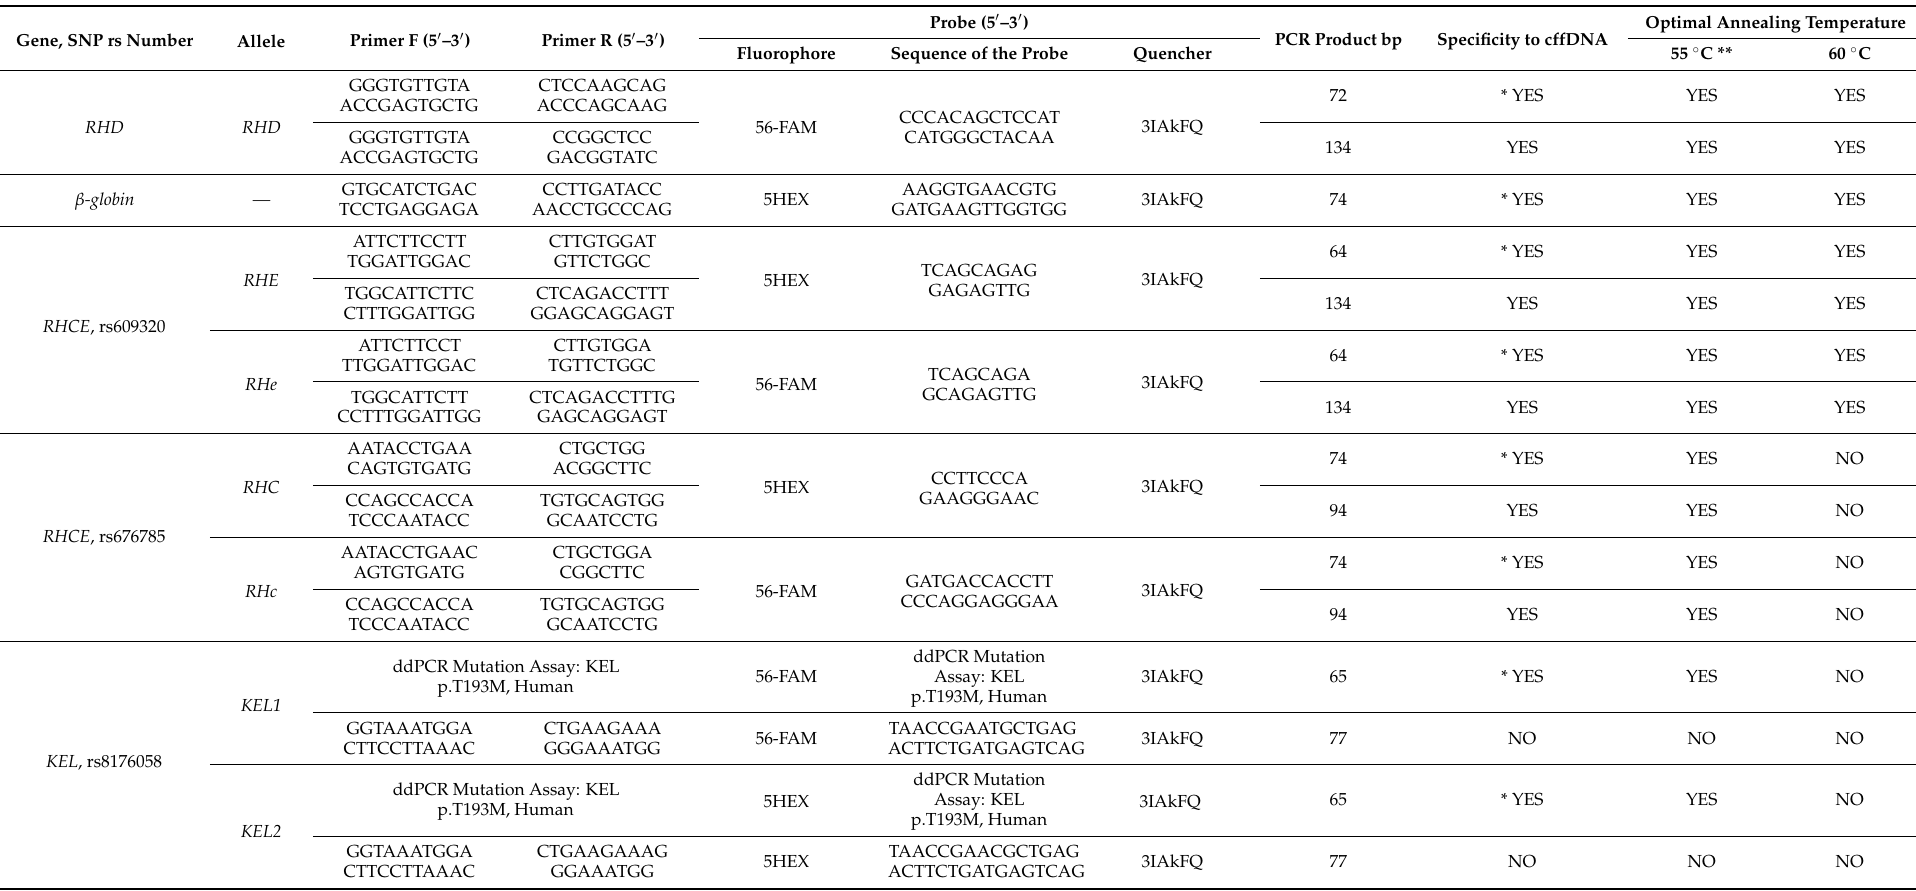
Table 2. Conditions of testing and optimization of ddPCR